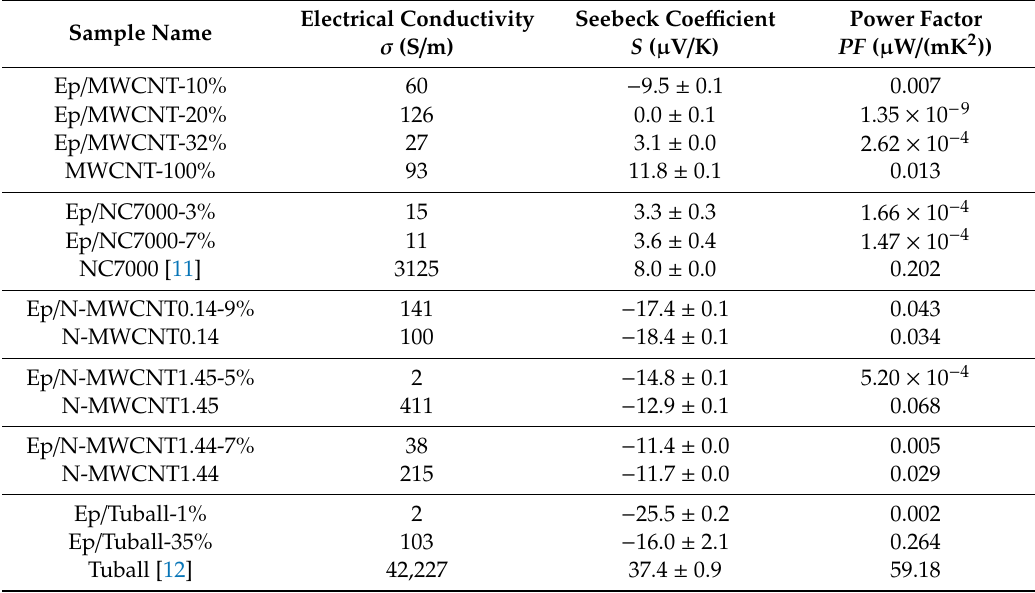
Figure 9. Seebeck coefficient of CNT buckypapers and epoxy composites in dependence on the CNT content sorted by color: lab-made MWCNT ( blue ), commercial MWCNTs ( green ), lab-made N-MWCNTs ( red ), commercial SWCNT ( black ). Table 2. Comparison of electrical conductivity σ , Seebeck coe ffi cient S , and power factor PF of epoxy / CNT composites and CNT